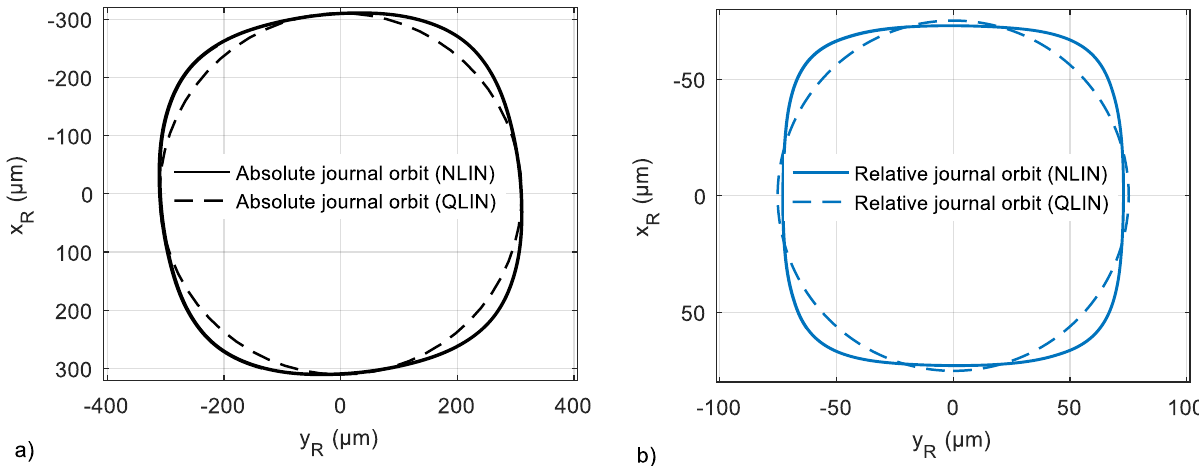
Figure 17. ( a ) Absolute and ( b ) relative journal orbit of the NDE 4-tilting-pad bearing, non-linear (NLIN) and quasi-linear (QLIN) analysis, n = 2000 1/min, unbalance G6.3 (75%). (QLIN) analysis, n = 2000 1/min, unbalance G6.3